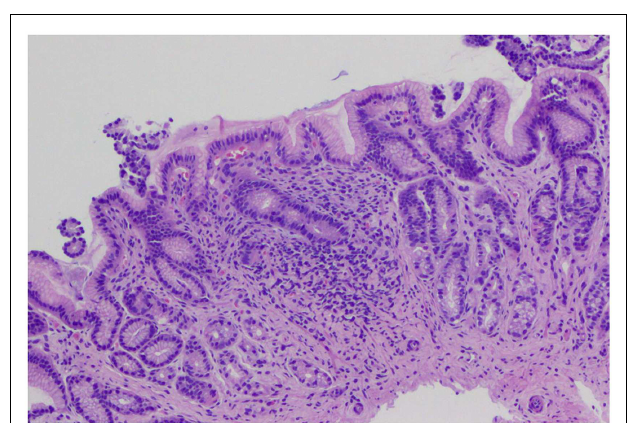
FIGURE 2 | Gastric biopsies with non-specific gastric inflammation . Gastric antral-type mucosa at low power with lymphoplasmacytic inflammation expanding the lamina propria.The general architecture is preserved with no erosions or acute inflammation.